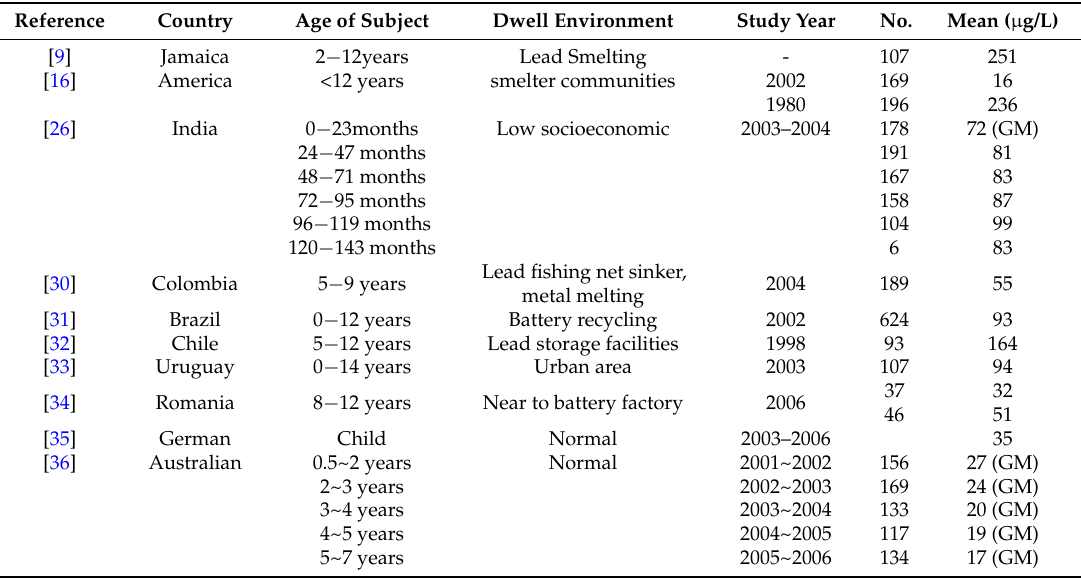
Table 8. The BLLs in children in some recent research